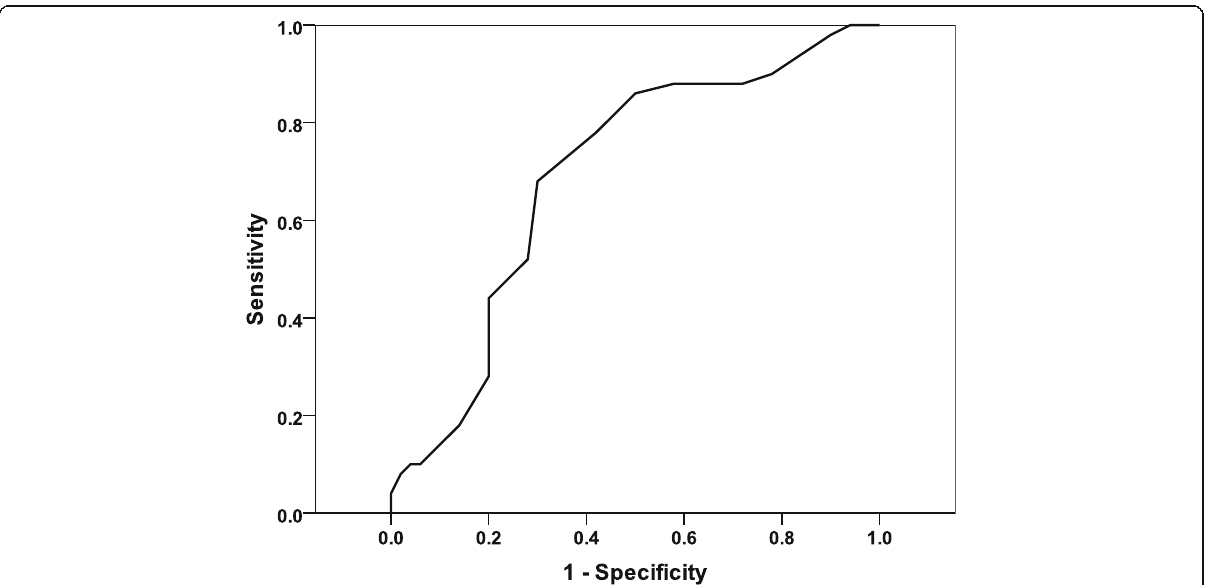
Fig. 2 ROC curve for RRI in differentiation between NASH patients and simple